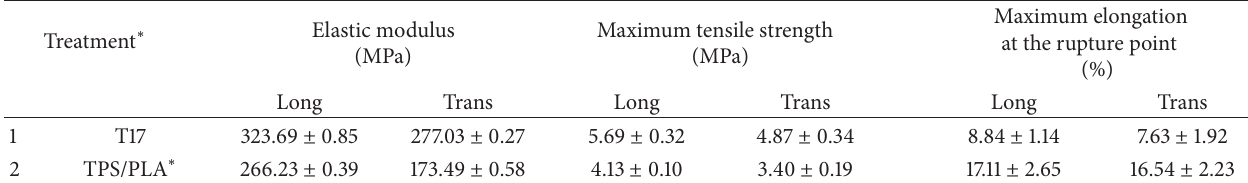
Table 2: Comparison results of tensile mechanical properties.